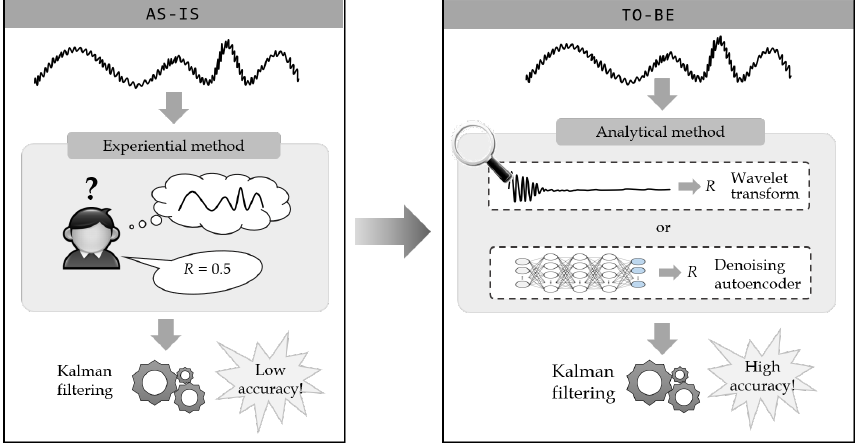
Figure 3. Decision process of the measurement noise variance R in existing and proposed methods.